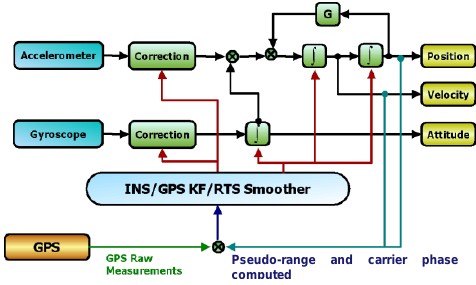
Figure 4: The integration architecture of TC (closed loop)